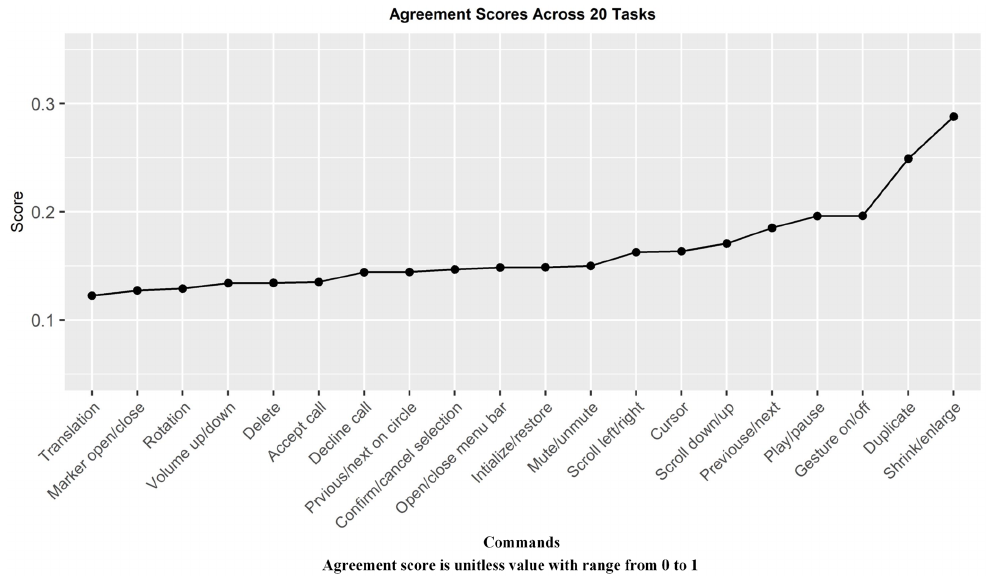
Figure 6. The agreement scores for the 20 commands when calculated using the 2 to 4 microgestures preferred for a command.